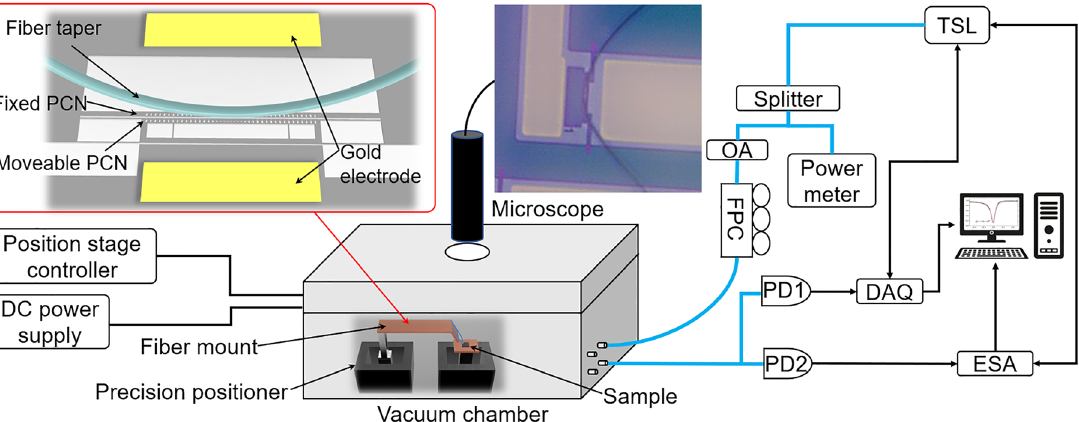
Figure 3: Experimental setup for the optomechanical electrometer. Inset indicates the precise alignment of fiber taper and on-chip zipper cavity. A microscopic image shows the observation of fiber taper attached to the fixed PCN